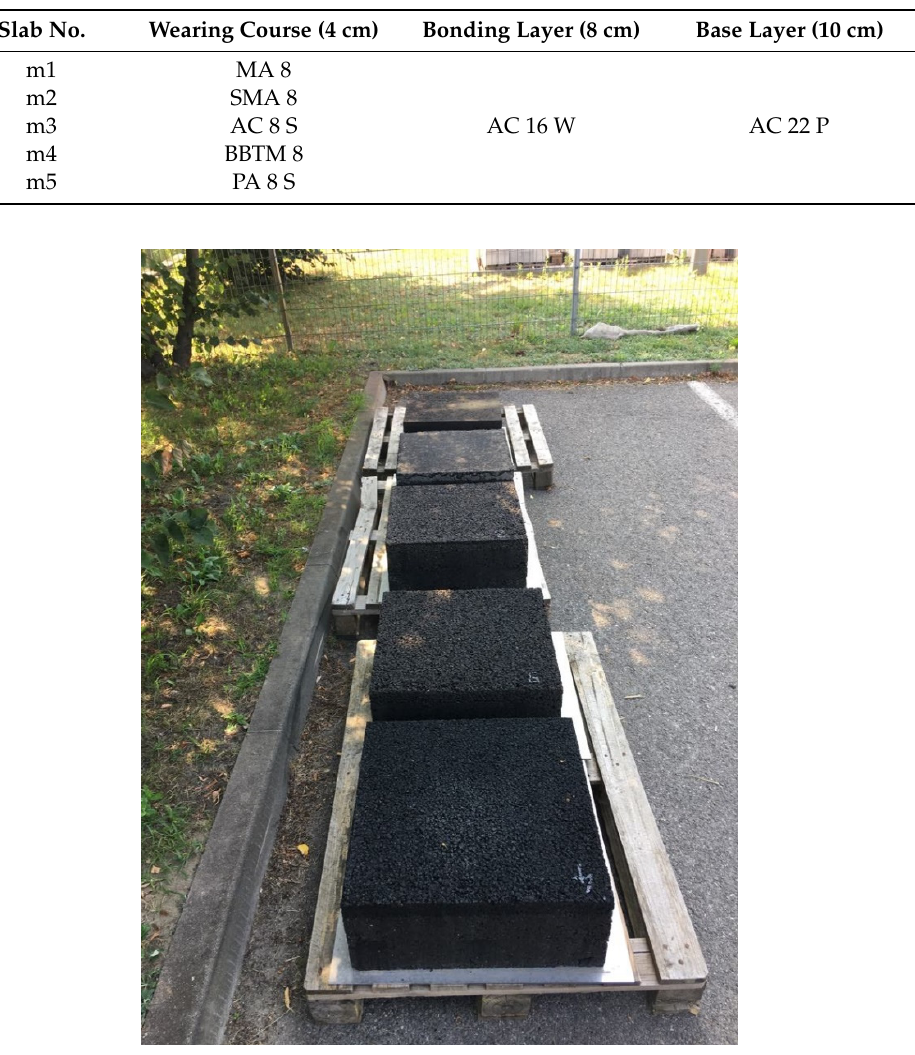
Table 2. Constructions of model asphalt slabs.